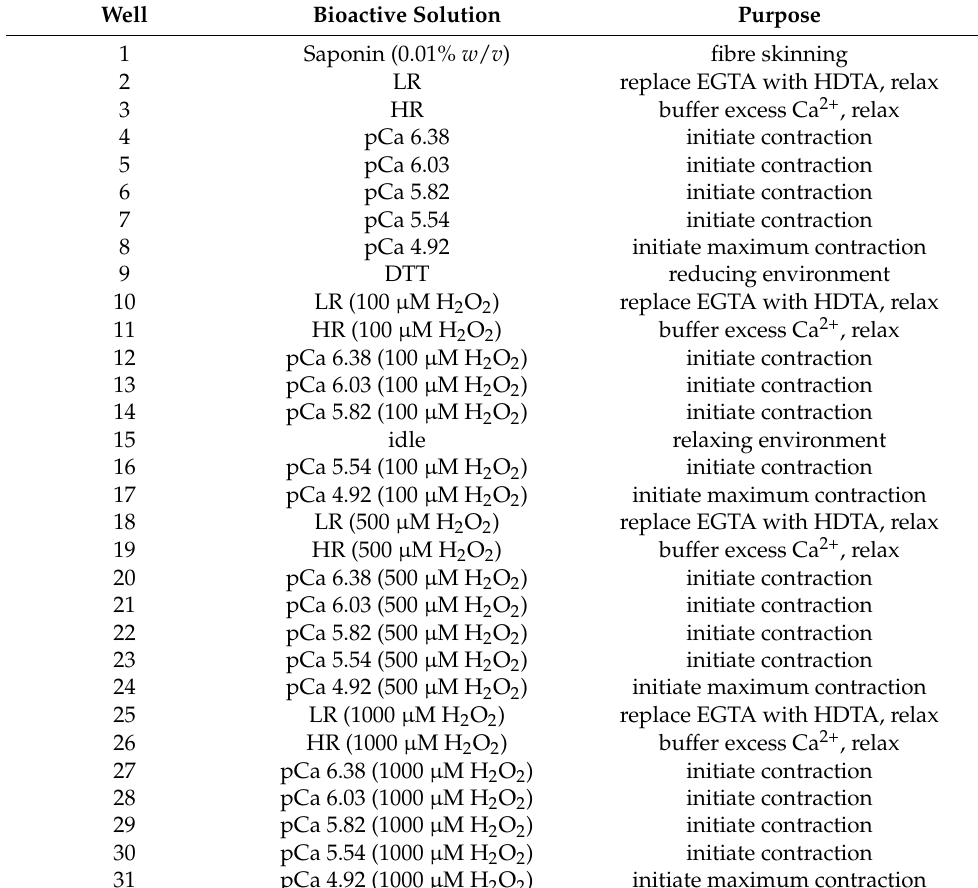
Table 1. Setup of bioactive solutions in the MyoRobot